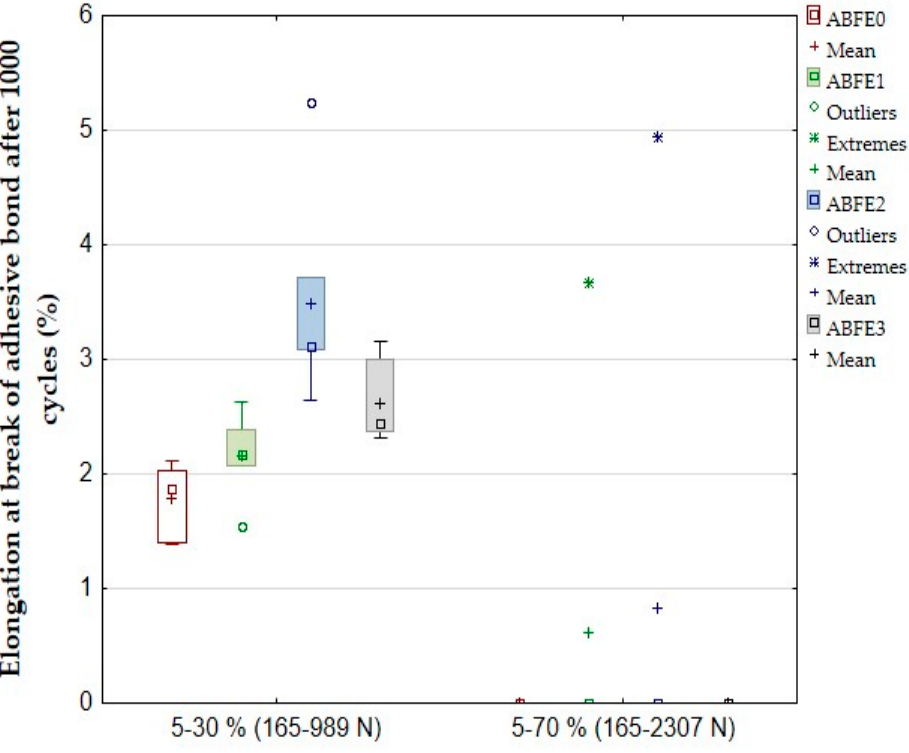
Figure 9. Quasi-static test of adhesive bonds—elongation at break after 1000 cycles.